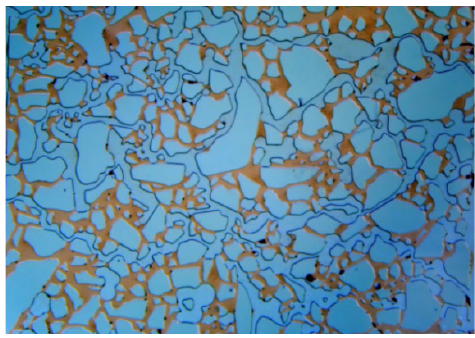
Figure 15. Remaining oil occurrence at 20 MPa and 15 min.